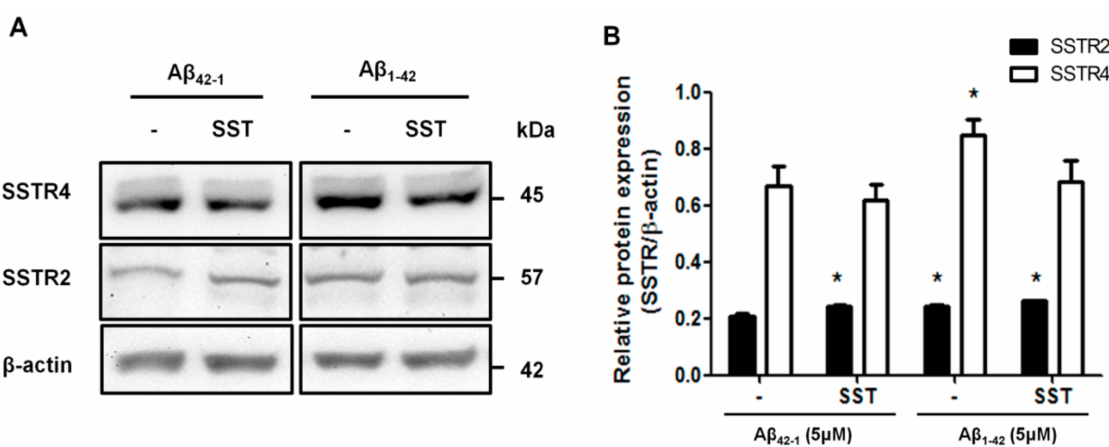
Figure 5. SST-induced changes in SSTR2 and SSTR4 expressions. ( A ). Representative Western blot showing the effect of SST in the expression of SSTR2 and 4. ( B ). The densitometry analysis of the Western blot shows that the treatment of cells with SST resulted in a significant increase in SSTR2 expression in the presence of either A β 42-1 or A β 1-42 . SSTR4 expression increased following the treatment with A β 1-42 . In contrast, the co-treatment of cells with A β 1-42 and SST resulted in the inhibition of A β 1-42 -induced upregulation of SSTR4. The data represent the mean ± SD of three independent experiments. * p < 0.05 against respective